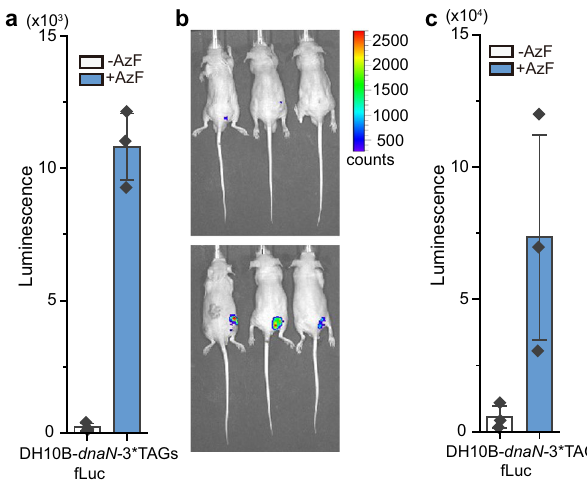
Fig. 6 Application of UAA-dependent synthetic auxotroph in living mice. a Bioluminescence intensity of UAA-dependent synthetic auxotroph constructed with 3TAGs in the dnaN gene in the presence or absence of AzF in vitro. b Bioluminescence imaging for UAA-dependent synthetic auxotroph in the absence (up) or presence (down) of AzF in living mice. Cells ( ∼ 1 × 10 8 cells/50 μ l) were subcutaneously injected into the mice (left legs, DH10B cell; right legs, UAA-dependent synthetic auxotroph expressing fLuc protein). The bioluminescent signal was measured in whole animals at 24 h after injection. c Statistic analysis of bioluminescent value in b . Error bars represents ±standard error of the mean from three biologically independent experiments. Source data are provided as a Source Data fi